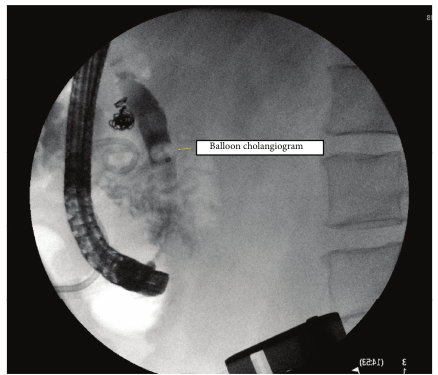
Figure 2: Stent in common bile duct.